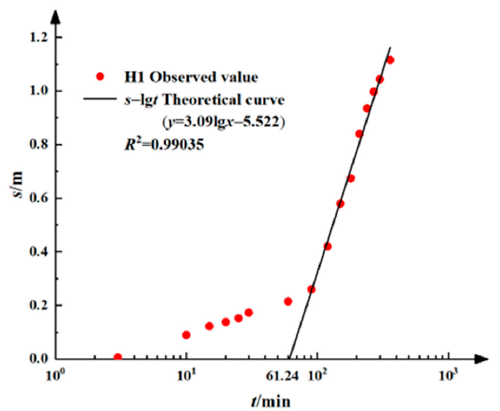
Figure 5. Drawdown versus semilogarithmic pumping time for observation well H1.